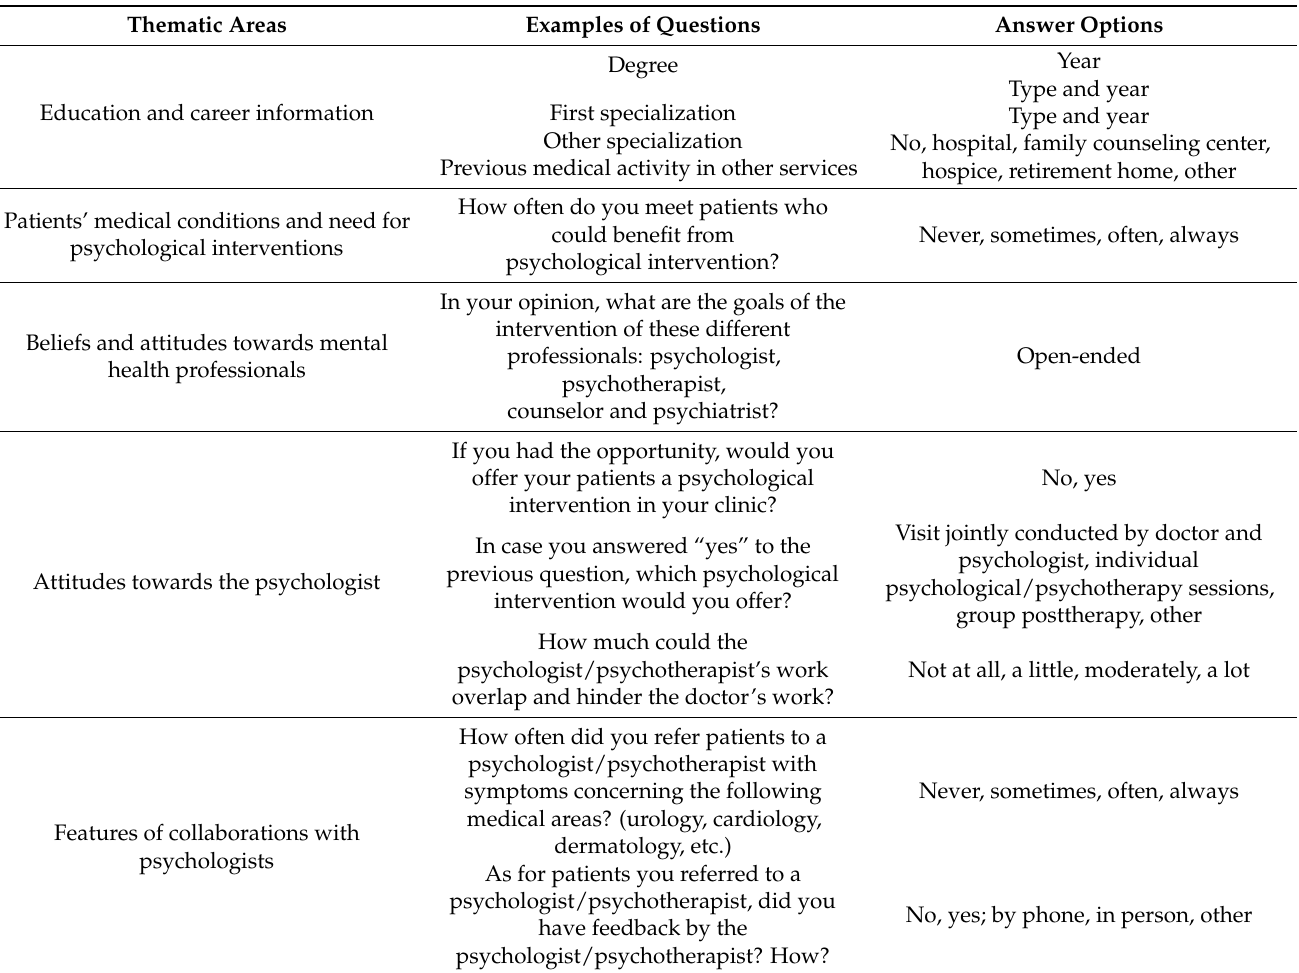
Table 1. Overview of the areas and questions of the